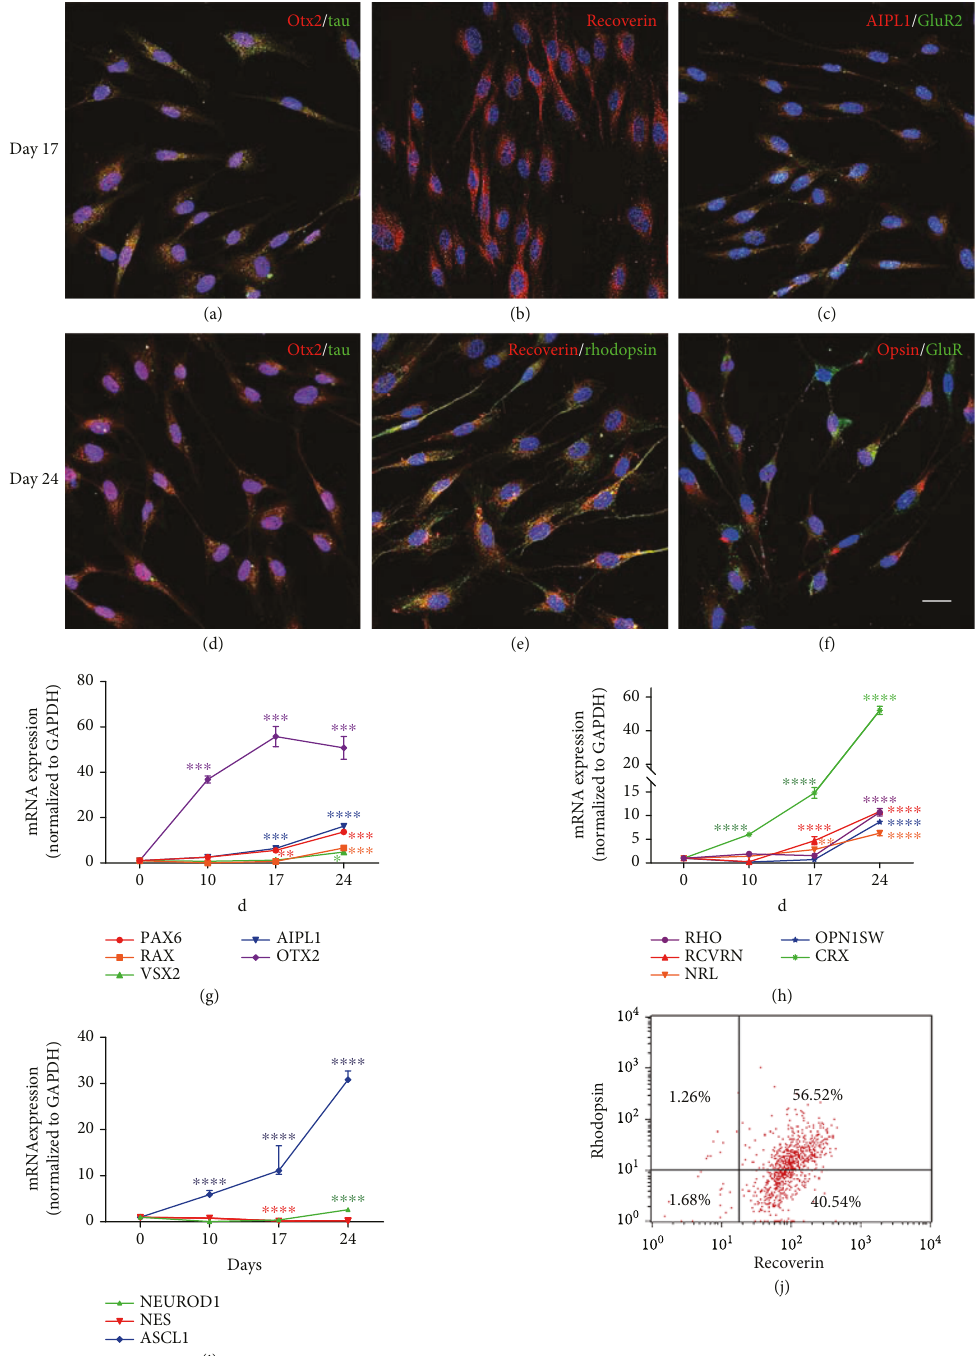
Figure 3: Characteristics of expression pro fi les of gene and protein biomarkers in photoreceptor-like cells derived from SHEDs after retinal induction. (a) – (c) Immuno fl uorescence images showing SHEDs expressing the retina-related neural markers tau (a) and GluR2 (c), the retina-related neural markers Otx2 (a) and AIPL1 (c), and the photoreceptor precursor marker recoverin (b) on day 17. (e)-(f) The rod marker rhodopsin (e) and the cone marker opsin (f) were detected on day 24, as were Otx2 (d), tau (d), GluR (f), and recoverin (e). Scale bars: 20 μ m. (g) – (i) q-PCR analysis showing that relative gene expression of the retinal progenitor markers PAX6, RAX, and VSX2 was upregulated, along with the retinal neural markers OTX2 and AIPL1 (g). The photoreceptor precursor markers RCVRN, CRX, and NRL showed an increasing trend, and the rod marker RHO and the cone marker OPN1SW were highly expressed at the fi nal stage of induction (h). In addition, there was an increasing trend in the expression of the proneural markers NEUROD1 and ASCL1, but a decreasing trend in the expression of the neural crest cell marker NES (i) ( ∗ p < 0 05 , ∗∗ p < 0 01 , ∗∗∗ p < 0 001 , and ∗∗∗∗ p < 0 0001 ). (j) Flow cytometry analysis showing the percentages positive for recoverin, rhodopsin, or both of